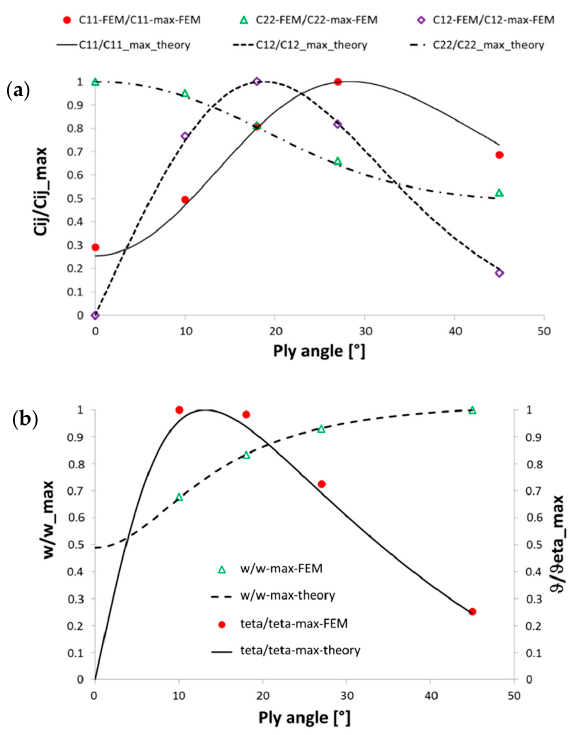
Figure 7. ( a ) Sti ff ness coe ffi cients for the selected configuration vs. ply angle ( b ) deflection ( w ) and Figure 7. ( a ) Stiffness coefficients for the selected configuration vs ply angle ( b ) deflection ( w ) and rotation ( ϑ ) vs. ply rotation ( ϑ ) vs ply angle.